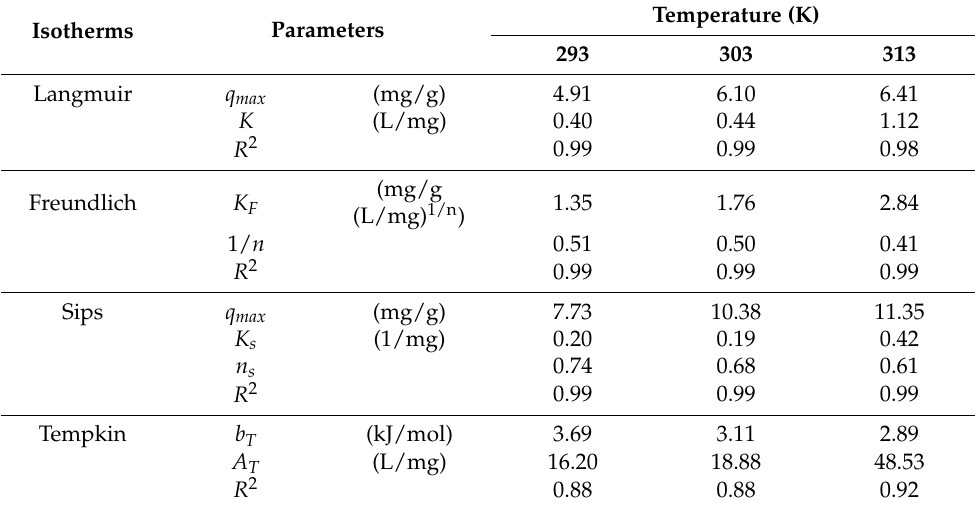
Table 2. Summary of the adsorption model parameters for Co(II) onto the b-HdA at various temperatures.